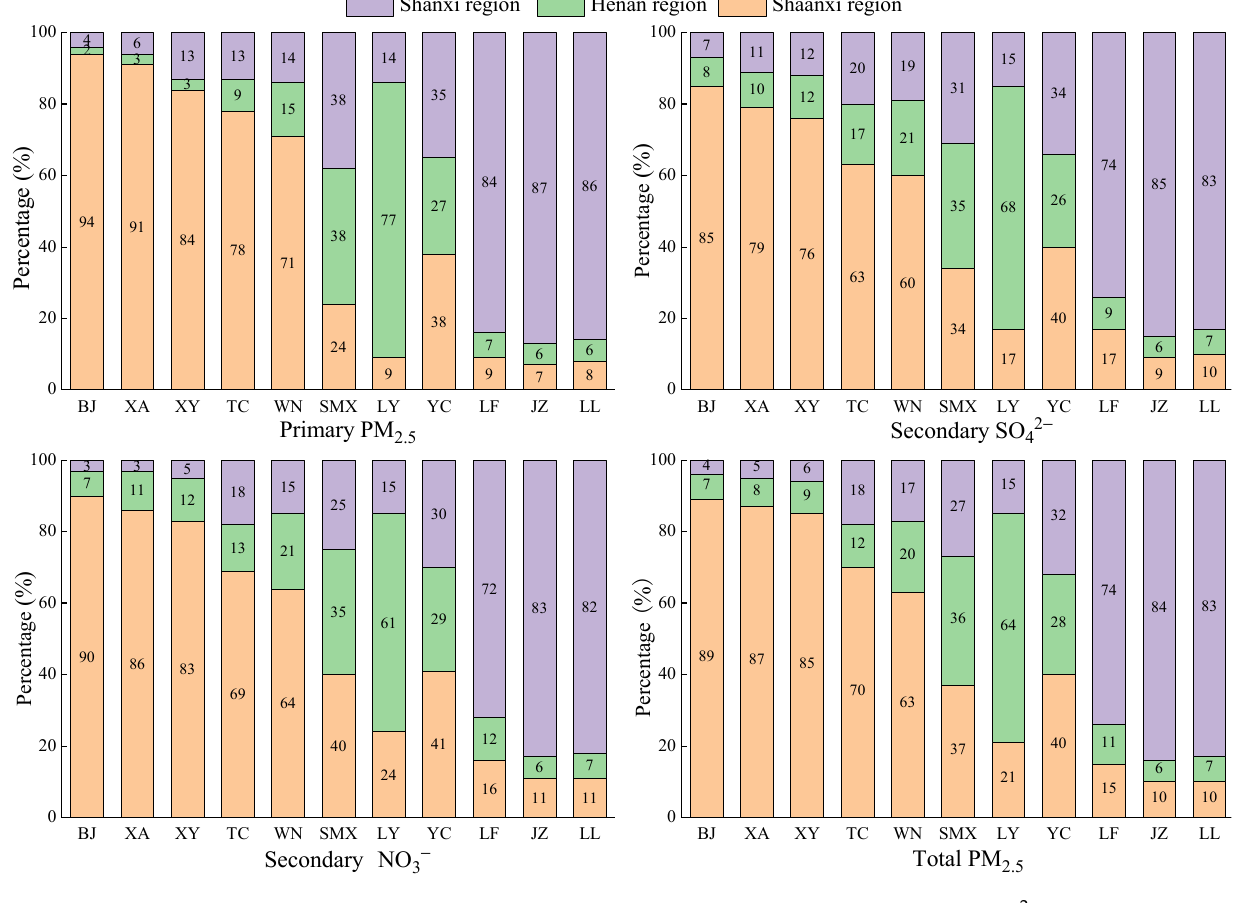
Figure 7. Concentration contributions of primary PM 2.5 , secondary SO 42 − , secondary NO 3 − , and total PM 2.5 in all cities in the FWP in January 2019.